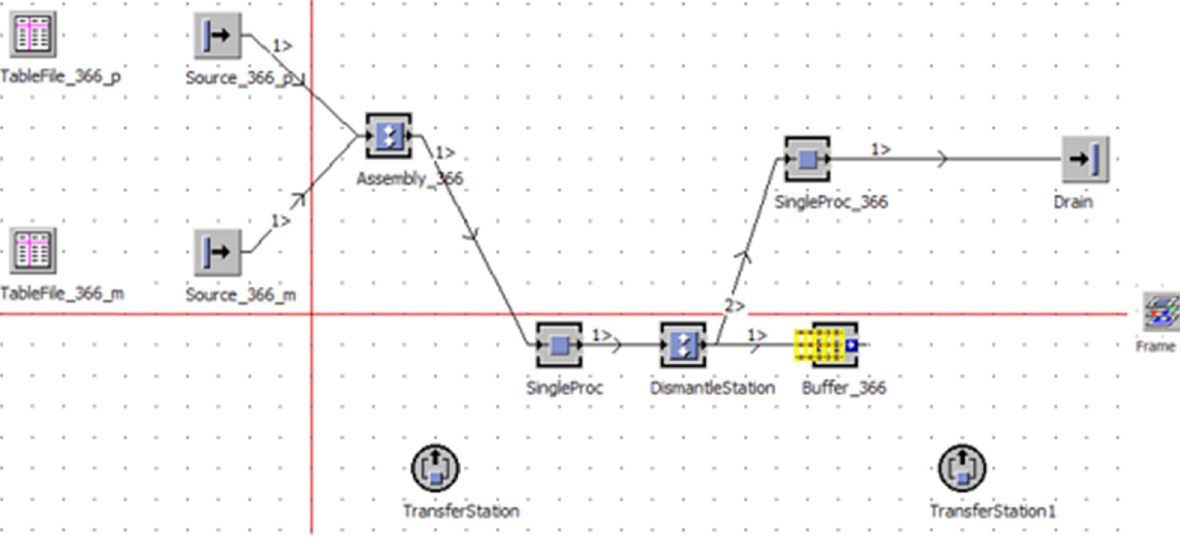
Figure 4: Demonstration of part of the supply process model.